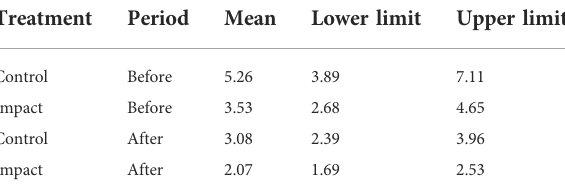
TABLE 5 Adjusted mean of species richness and 95% con fi dence interval for treatment and period. Treatment